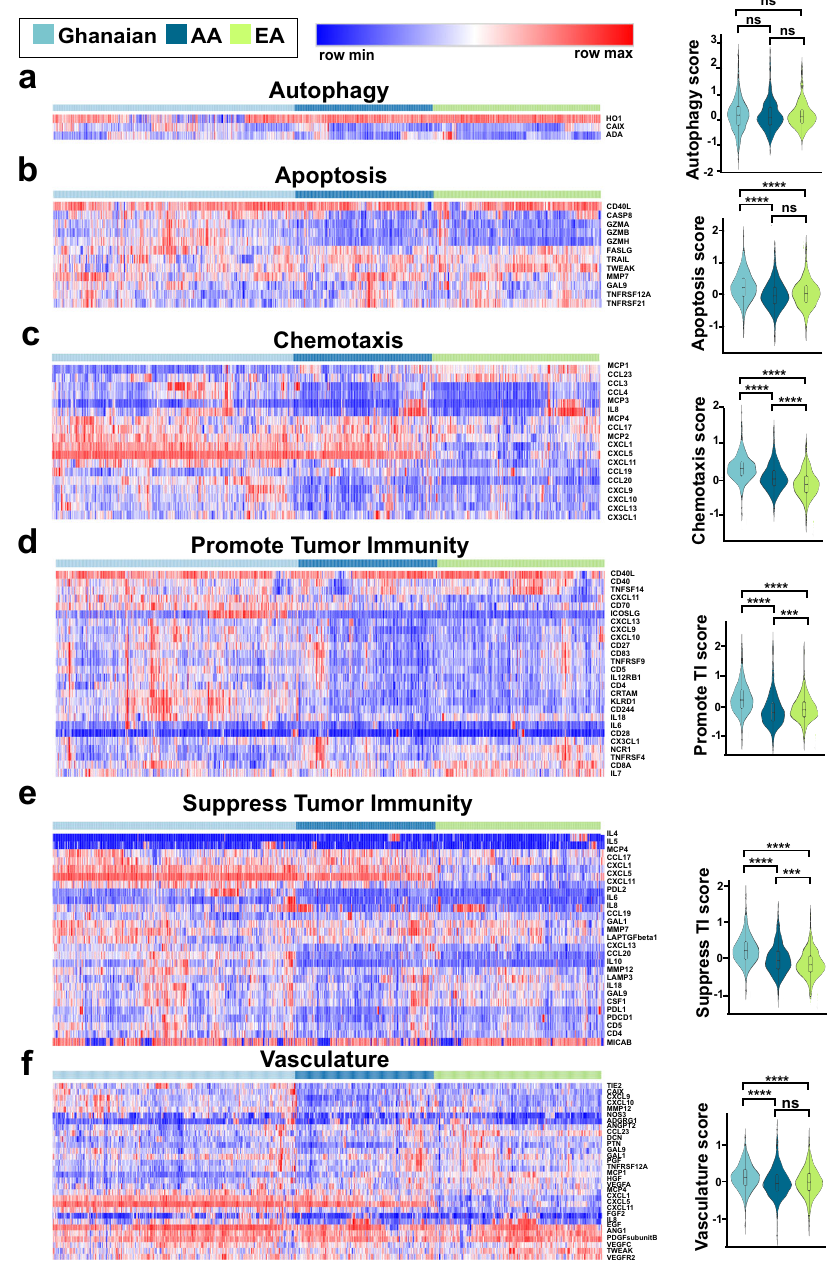
Fig. 5 Population differences in proteome-de fi ned pathway activity scores. Shown are population differences in the abundance of proteins driving ( a ) autophagy, ( b ) apoptosis, ( c ) chemotaxis, ( d ) promotion of tumor immunity, ( e ) suppression of tumor immunity, and ( f ) vasculature. Heatmaps despict levels of process/pathway-associated proteins in relationship to population group (Ghanaian, AA, EA). Shown to the right are the mean score differences for these processes/pathways among the three population groups. Pro fi les for Ghanaian ( n = 654), AA ( n = 374), and EA ( n = 454) men without prostate cancer are shown. The process/pathway scores are derived from the average z -scores of all the associated proteins. These scores are shown as violin plots and were compared using two-sided Wilcoxon rank sum tests. P values were adjusted for multiple comparison. FDR-adjusted P value signi fi cance was coded as <0.0001 (****), <0.001 (***), and ≥ 0.05 (ns). The violin plots represent median values ± IQR. Source data are provided as